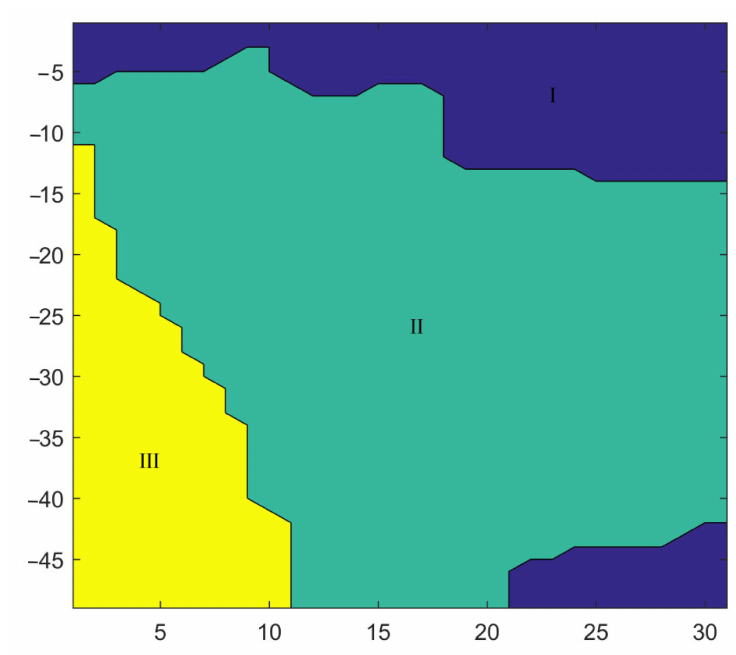
Figure 31. Schematic diagram of safety risk level partition of adjacent construction.